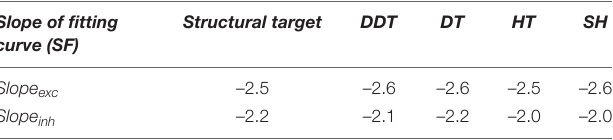
TABLE 4 | Slope of the fitting power law for SF network degree distrinution using the different thresholding methods. Slope of fitting curve